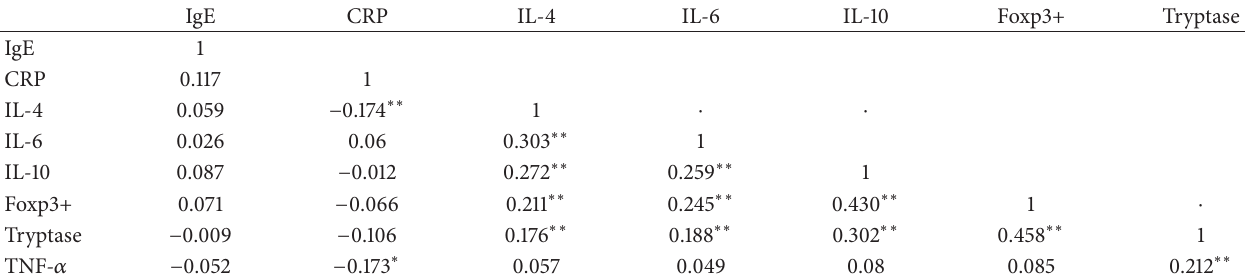
Table 3: Spearman correlation coefficients between inflammatory markers in normal glucose group.